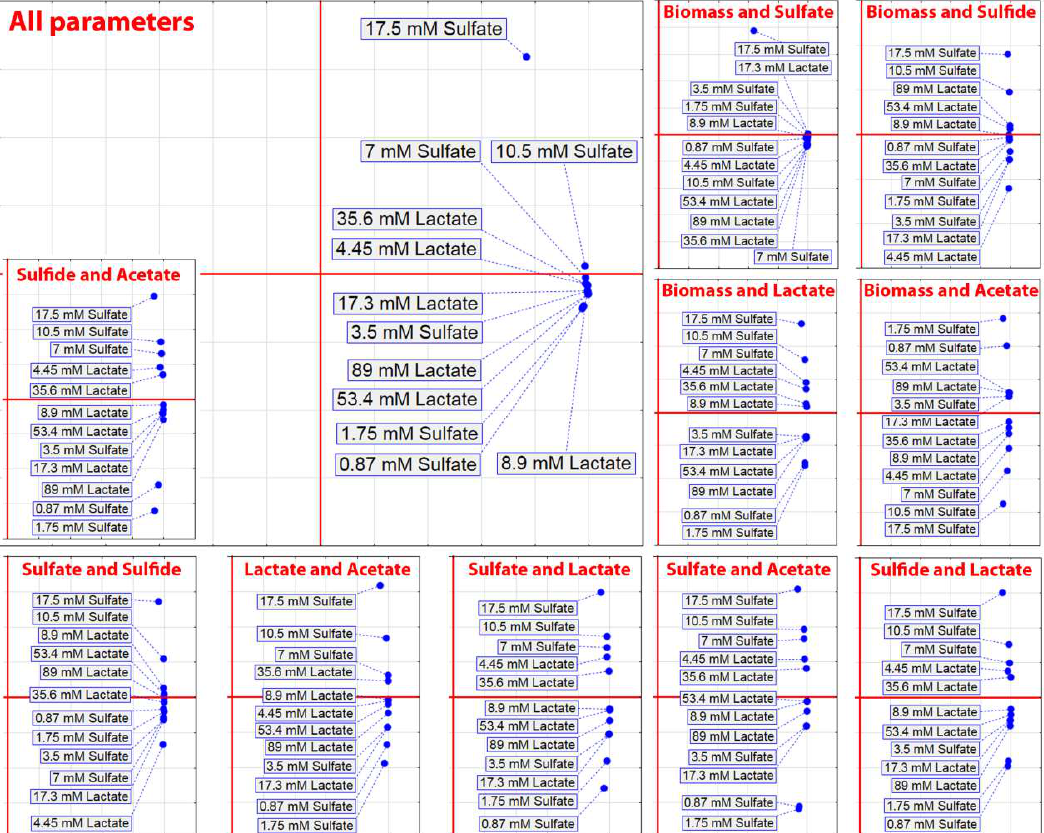
Figure 5. Principal component analysis of the D. piger Vib-7 growth and the parameters of sulfate reduction based on cross-correlation analysis.